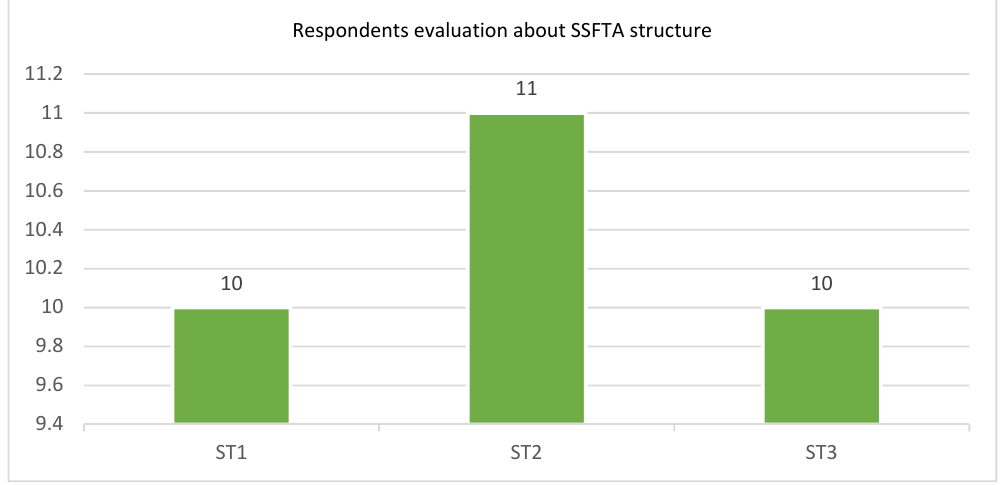
Figure 6. Evaluation of SSFTA structure .